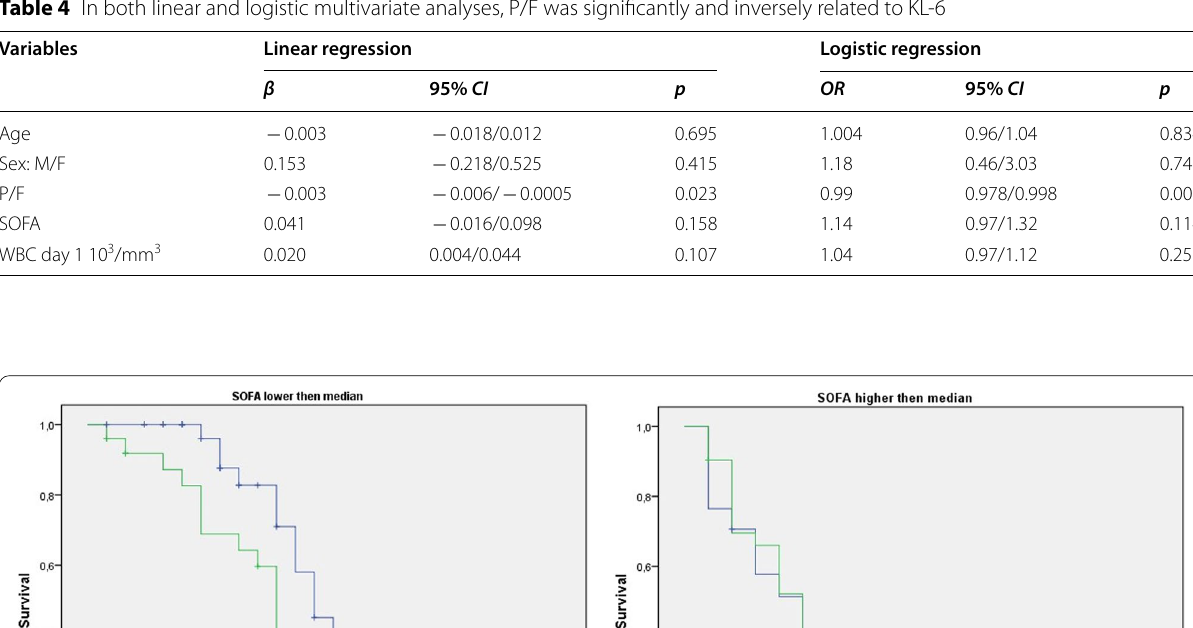
Table 3 Univariate linear and logistic regression analysis. The two groups differed for P/F value ( p Variables